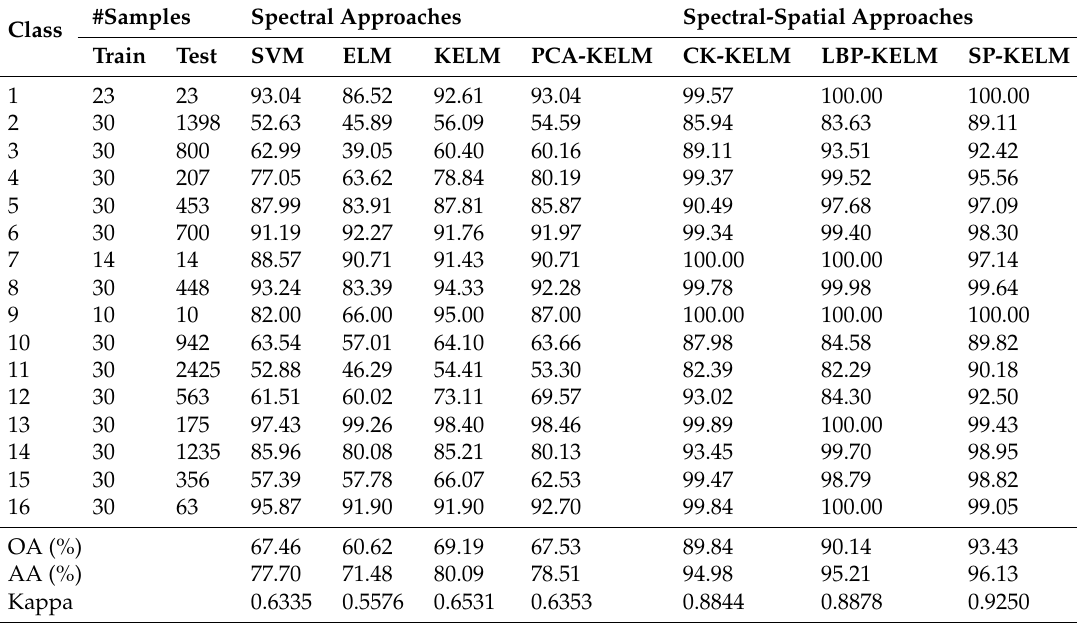
Table 2. Performance comparison of all compared methods on the Indian Pines